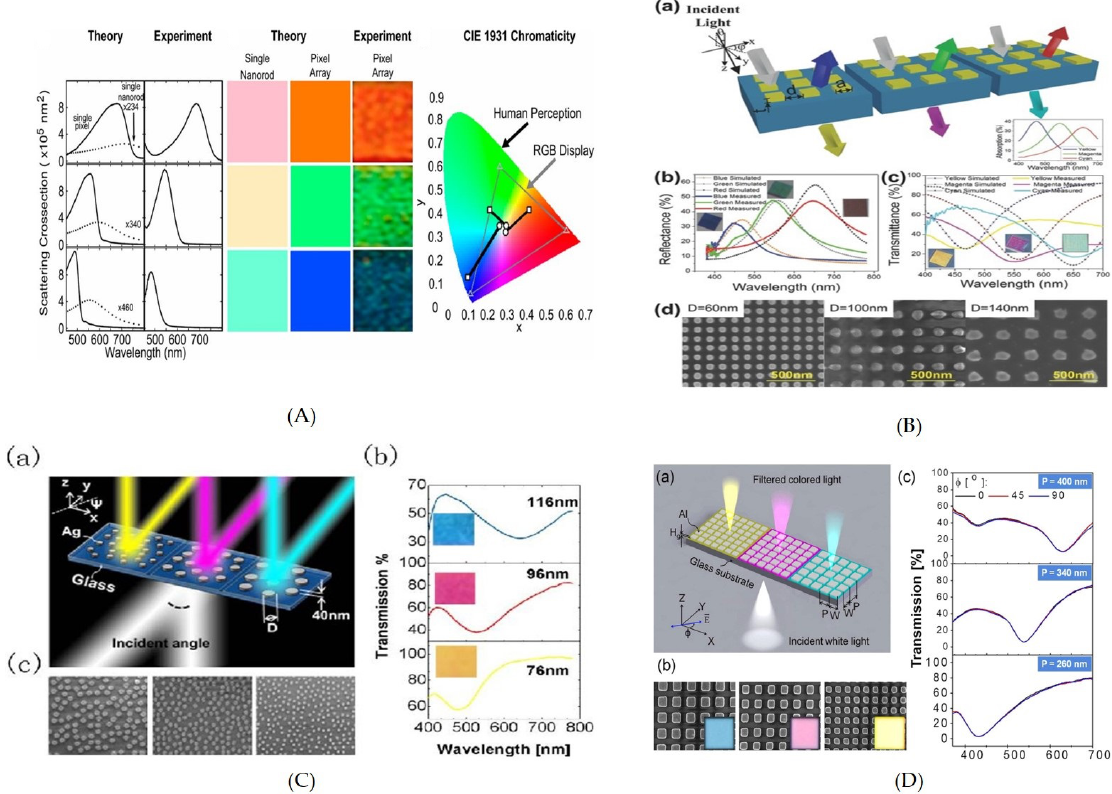
Figure 6. ( A ) Experimental and theoretical results of vivid colors produced due to Al nanorod as a single nanorod and in hexagonal array [189]. ( B ) Schematic diagram of Ag nanopatch on glass substrate with different periodicities allowing angle invariant (up to 60 ◦ ) additive and subtractive color filtration in transmission and reflection respectively. The plot for simulated and experimental spectra with the color image inset shows the obtained results. SEM gives a close look at the fabricated nanopatch array. Reproduced with permission of [187]. Copyright John Wiley & Sons, 2016. ( C ) schematic diagram of randomly distributed Ag nanodisks, the λ res was swept by varying the diameter of the nanodisks. The transmission spectra with color image in inset shows the color quality produced. Reproduced with permission of [190]. Copyright The Optical Society, 2013. ( D ) Schematic diagram of thin Al nanopatch array on a glass substrate, this design filters out white color into distinct subtractive colors by varying the pitch of array. The color quality is evident in SEM and camera image of the fabricated filters. The polarization independence is verified by plotting reflection spectra at different polarization angles. Reproduced with permission of [191]. Copyright American Chemical Society,